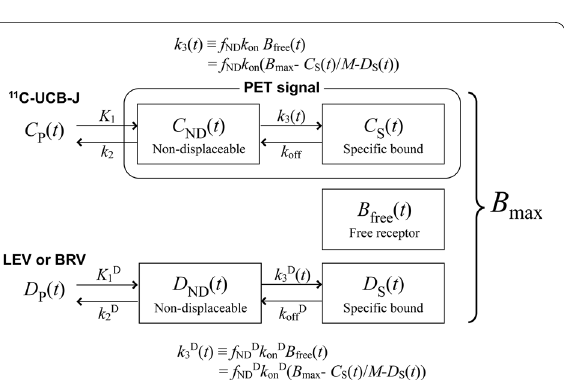
Fig. 1 Compartment model for 11 C‑UCB‑J and antiepileptic